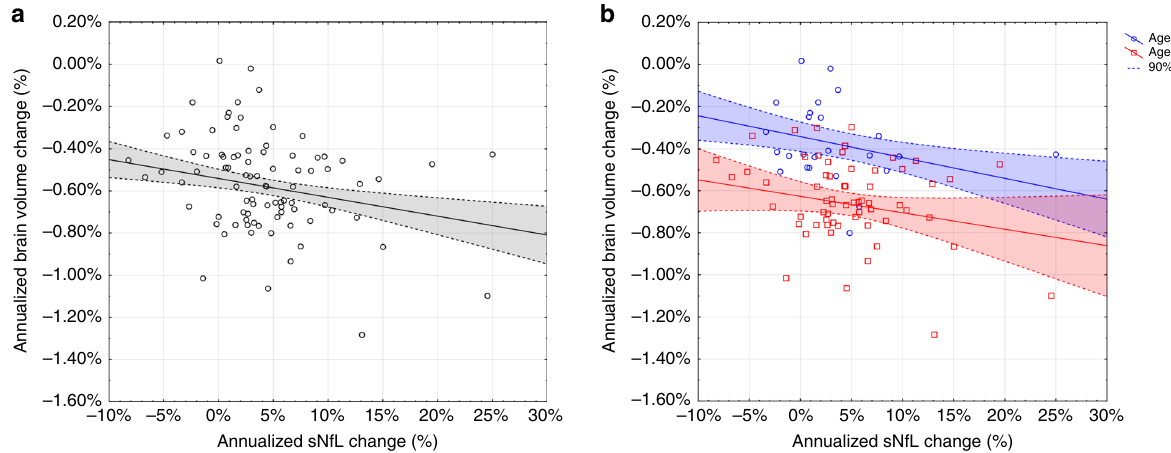
Fig. 5 Brain atrophy and change in sNfL. Association between brain atrophy and change in sNfL per year in the entire cohort ( a ) ( r s = − 0.290, p < 0.01) and divided in younger (age < 60 years = blue) and older subjects (age > 60 years = red) ( b ). In linear regression analyses, the annualized change in sNfL was identi fi ed as independent factor for the development of brain atrophy when considering the entire cohort ( β = − 0.336, p < 0.001) ( a ) and older individuals (>60 years) ( β = − 0.393, p < 0.01) ( b ). The dashed lines represent the 90% con fi dence interval. Two data points are outside the scaled range, but included in the analyses. Source data are provided as a Source Data fi Baseline sNfL correlated negatively with the annualized MMSE score change over time when considering the entire cohort ( r s = − 0.273, p < 0.01) (Table 4). The annualized change in sNfL was unrelated to the annualized change in MMSE scores (Table 4, last row).